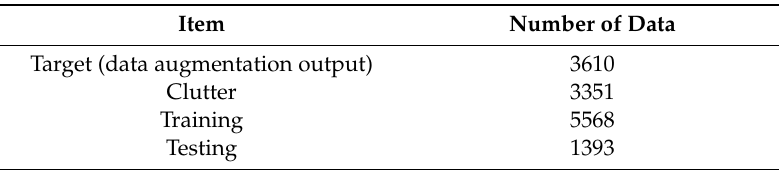
Table 1. Input data numbers.